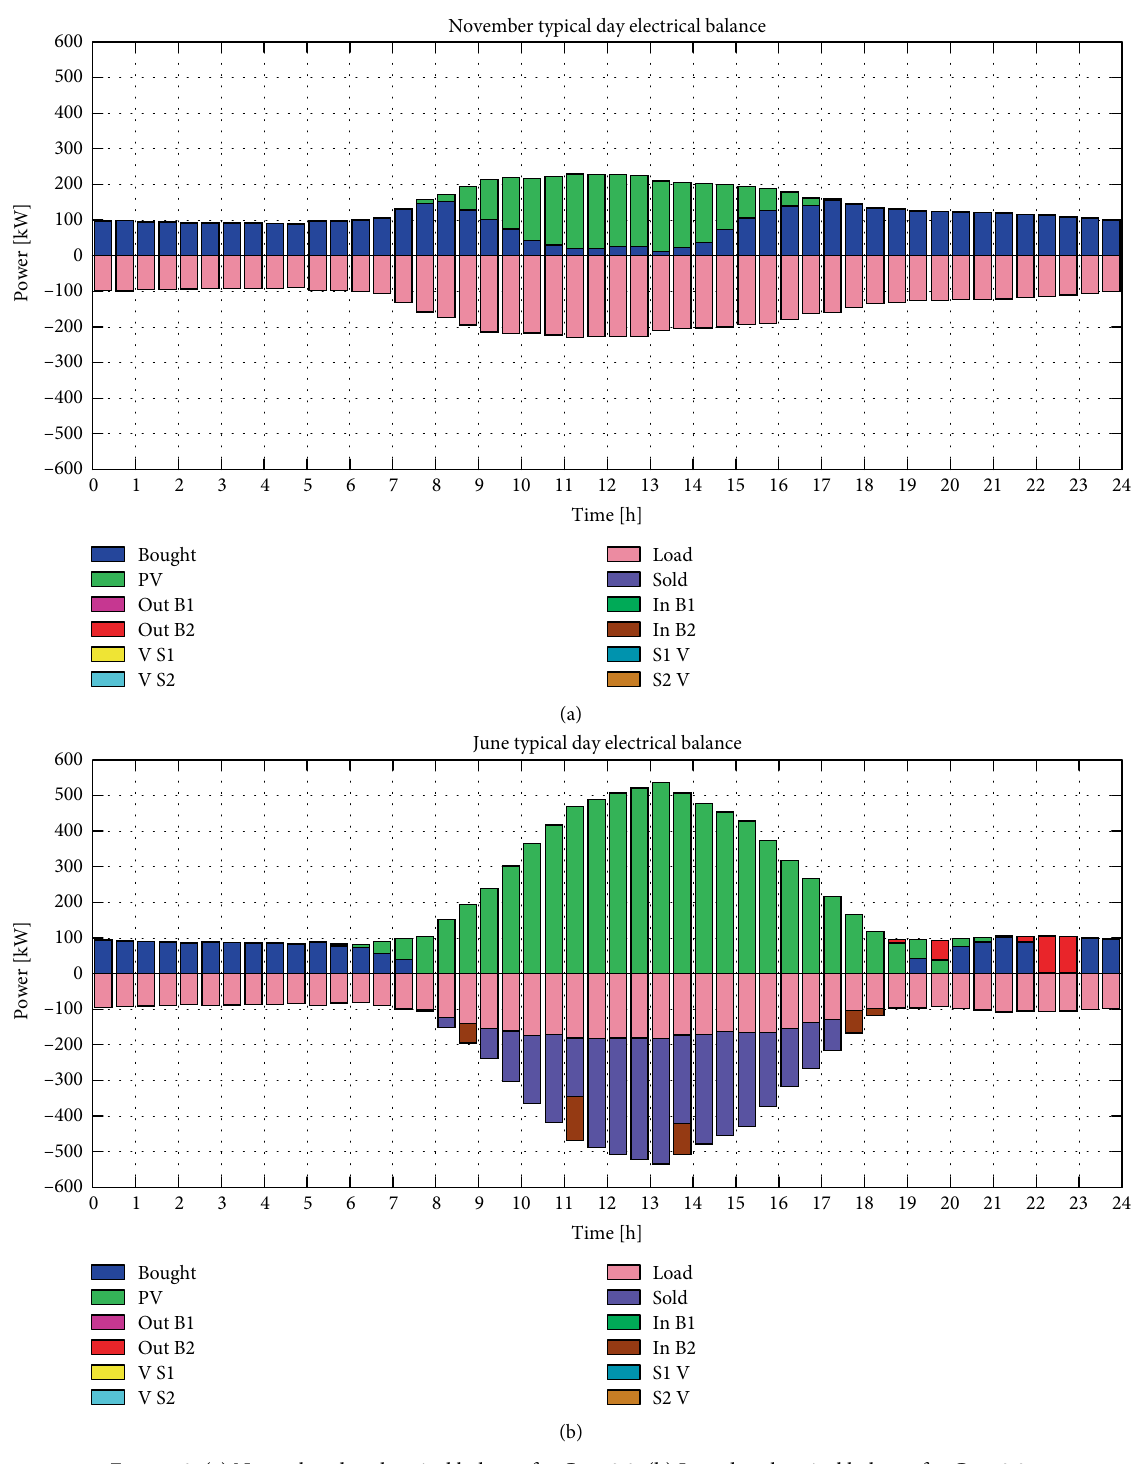
Figure 2: (a) November day electrical balance for Case 3.2. (b) June day electrical balance for Case